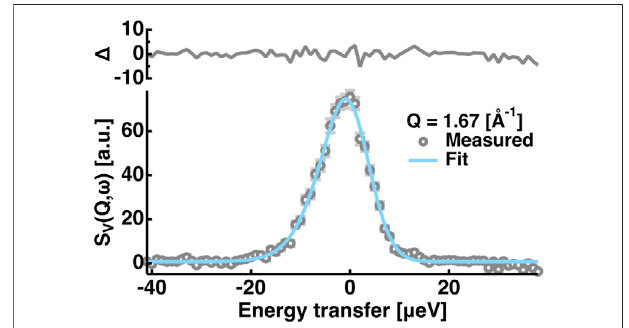
FIGURE 1 | Example of the fi tting of the QENS spectra of the vanadium. Those at Q (cid:2) 1.67 [Å − 1 ] are shown. Grey open circles denote the measured datapointsandthecyansolidlinedenotesthe fi t.Theresiduals( Δ )ofthe fi tting are shown in the upper side of the panel. Error bars are shown in light grey and they are within the symbols if not